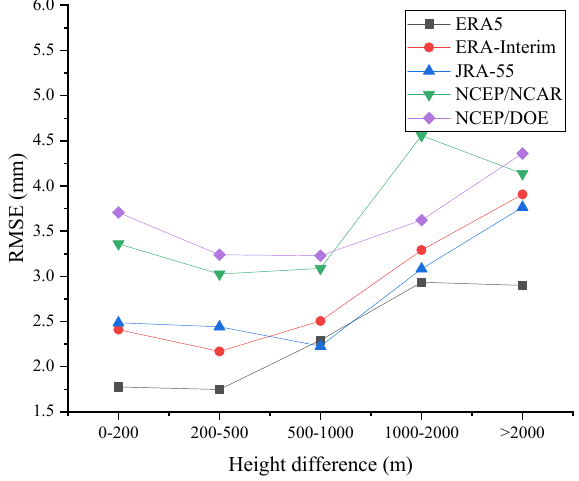
Figure 2. The change of RMSE values for ERA5, ERA-Interim, JRA-55, NCEP / NCAR, and NCEP / DOE reanalysis water vapor products relative to GNSS PWV with the change of height di ff erence between GNSS and five reanalysis products (source: own